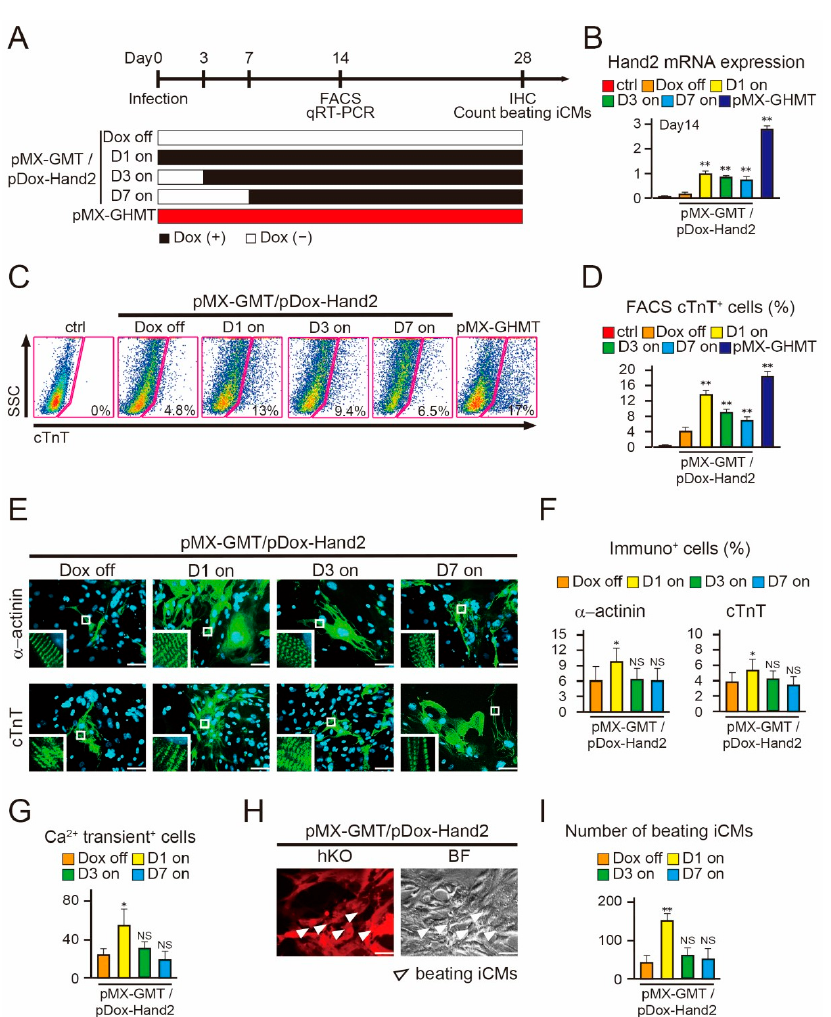
Figure 3. Initiating expression of Hand2 transgene one day after transduction promotes cardiac reprogramming. ( A ) Schematic representation of Hand2 transgene expression with temporal Dox addition. Mouse embryonic fibroblasts (MEFs) were infected with a mixture of pDox-Hand2 and pMX-GMT, and then Dox was added at day 1 (D1 on), day 3 (D3 on), and day 7 (D7 on) following transduction. Dox off indicates without Dox and pMX-GHMT (GMT plus Hand2) is the positive control; ( B ) qRT-PCR for Hand2 expression in the indicated samples after two weeks ( n = 3 independent triplicate experiments); ( C ) FACS analyses of cardiac troponin T (cTnT) expression in the indicated samples after two weeks; ( D ) quantitative data of ( C ) ( n = 3 independent triplicate experiments); ( E ) immunocytochemistry for α -actinin and cTnT after four weeks. The high-magnification views in the insets show the sarcomeric organization in cardiomyocyte-like cells (iCMs); ( F ) quantitation of the immunopositive ( α -actinin + and cTnT + ) cells ( n = 3 independent triplicate experiments); ( G ) total number of Ca 2+ oscillation + cells in ten randomly selected fields per well after four weeks ( n = 3 independent triplicate experiments). Movie S2 shows Ca 2+ imaging; ( H ) spontaneously beating iCMs in the pDox-Hand2/pMX-GMT-transduced MEFs after four weeks (D1 on, arrowheads), corresponding to Movie S3; ( I ) total number of beating cells in ten randomly selected fields per well ( n = 3 independent triplicate experiments). All data are presented as mean ± SD. * p < 0.05, ** p < 0.01 vs. the relevant control; NS = not significant. The scale bars represent 100 µ